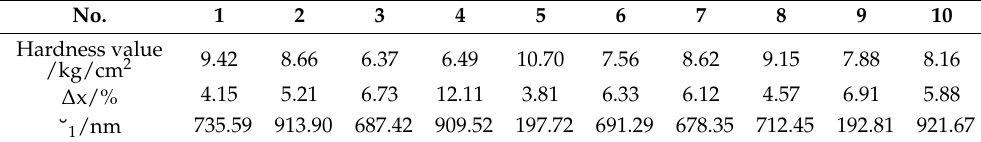
Table 6. Kiwifruit hardness test statistics